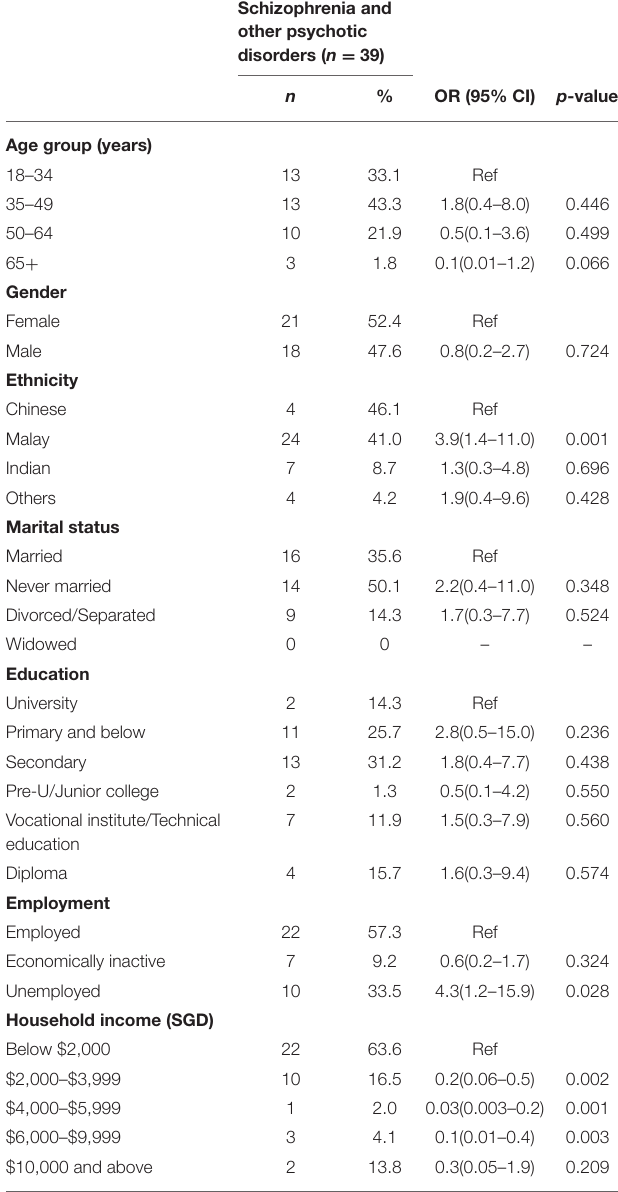
TABLE 2 | Lifetime prevalence of schizophrenia and other psychotic disorders in the SMHS 2016.